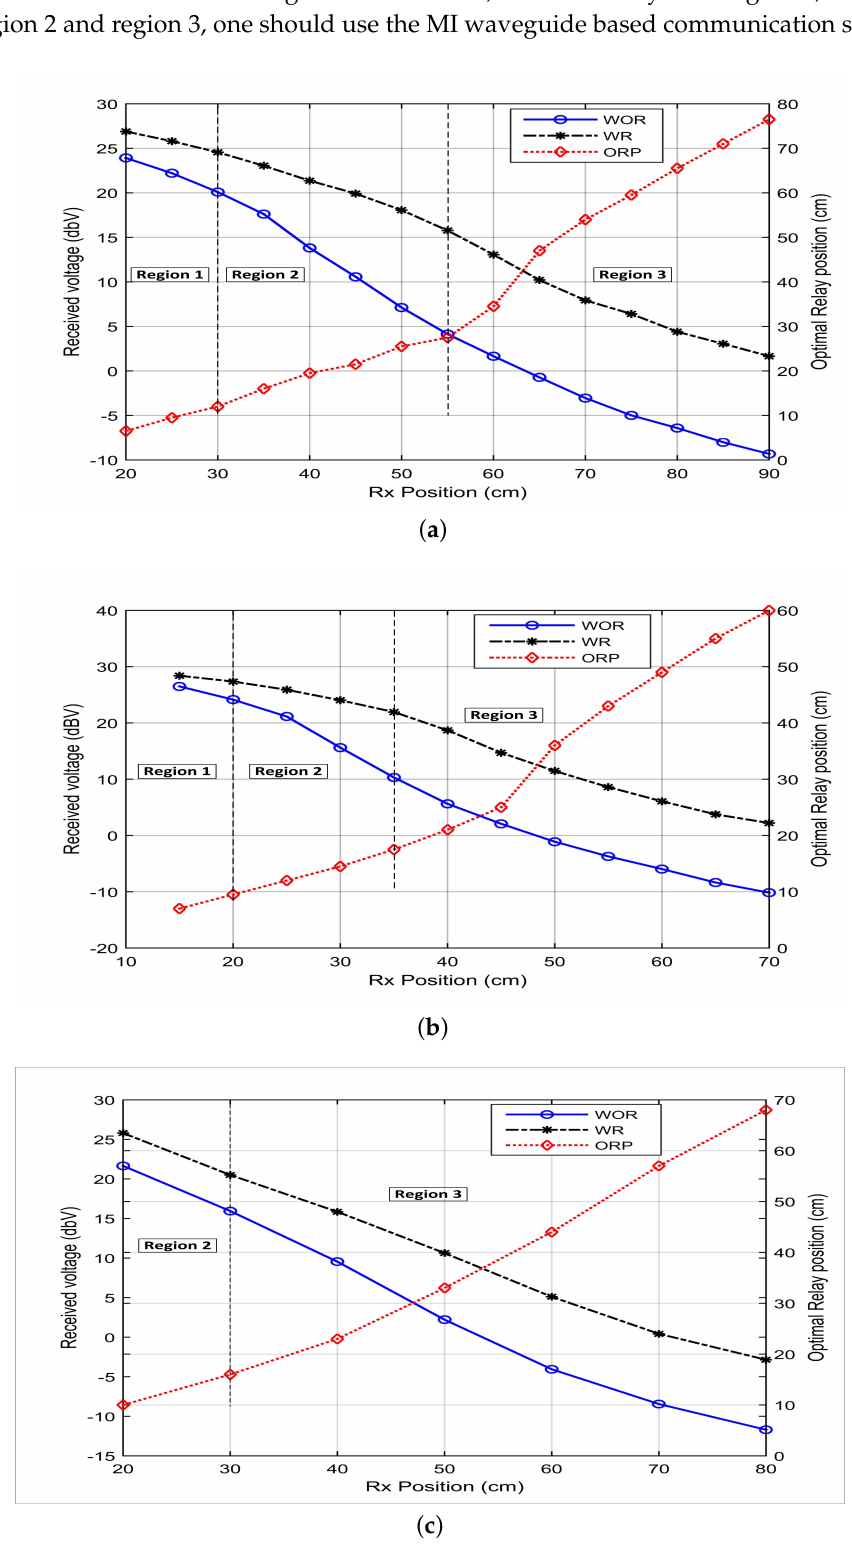
Figure 7. Received voltage with and without relay vs. receiver position when: ( a ) r = 15 cm and N = 10, ( b ) r = 10 cm and N = 20, and ( c ) r = 8 cm and N =